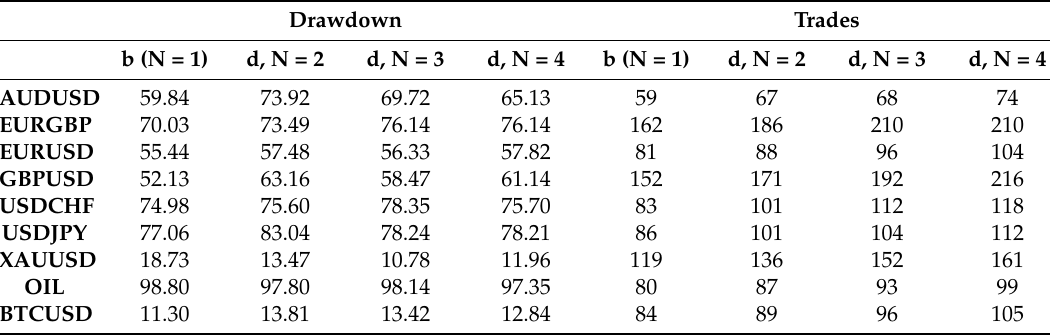
Table A4. Additional results of experiment (d) for various values of